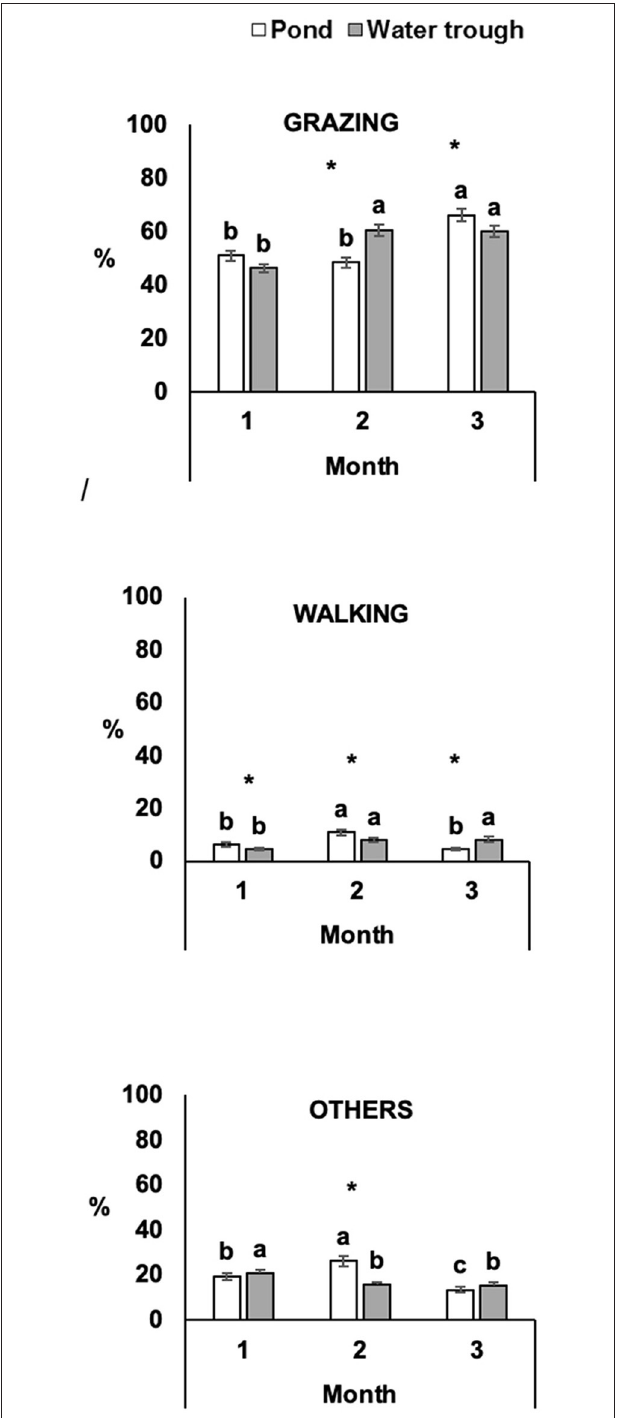
FIGURE 1 | Effect of treatment and period on steer behavior (least square means ± s.e.m.). Grazing, walking, and other behaviors are expressed in least square means ± s.e.m. of the percentage of animals performing each behavior on the three periods of observation. Different letters “a, b, c” represent significant differences ( P ≤ 0.05) between periods of observation within treatment. “*” represents significant differences ( P ≤ 0.05) between treatments within the period of observation.